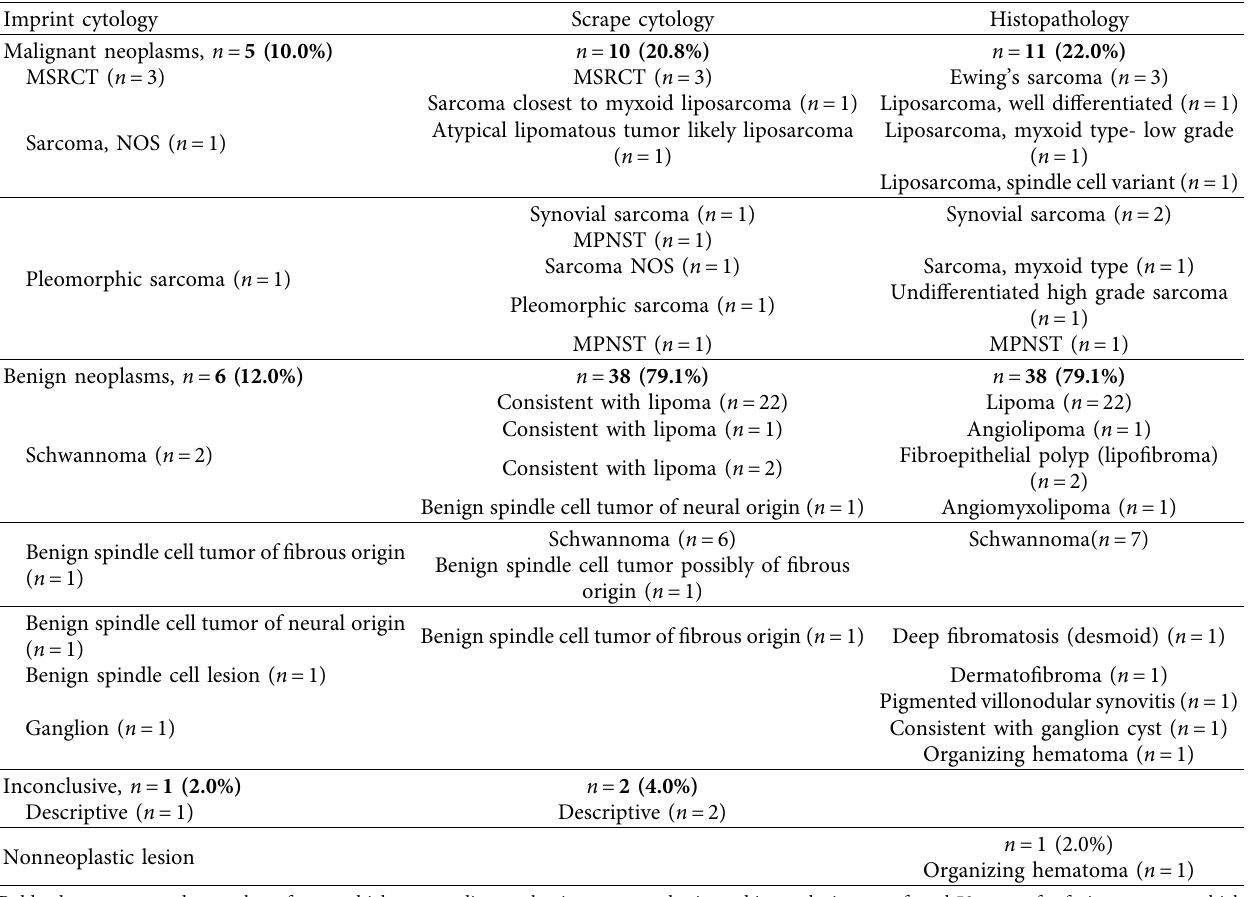
Table 1: Comparison of imprint and scrape cytology and final